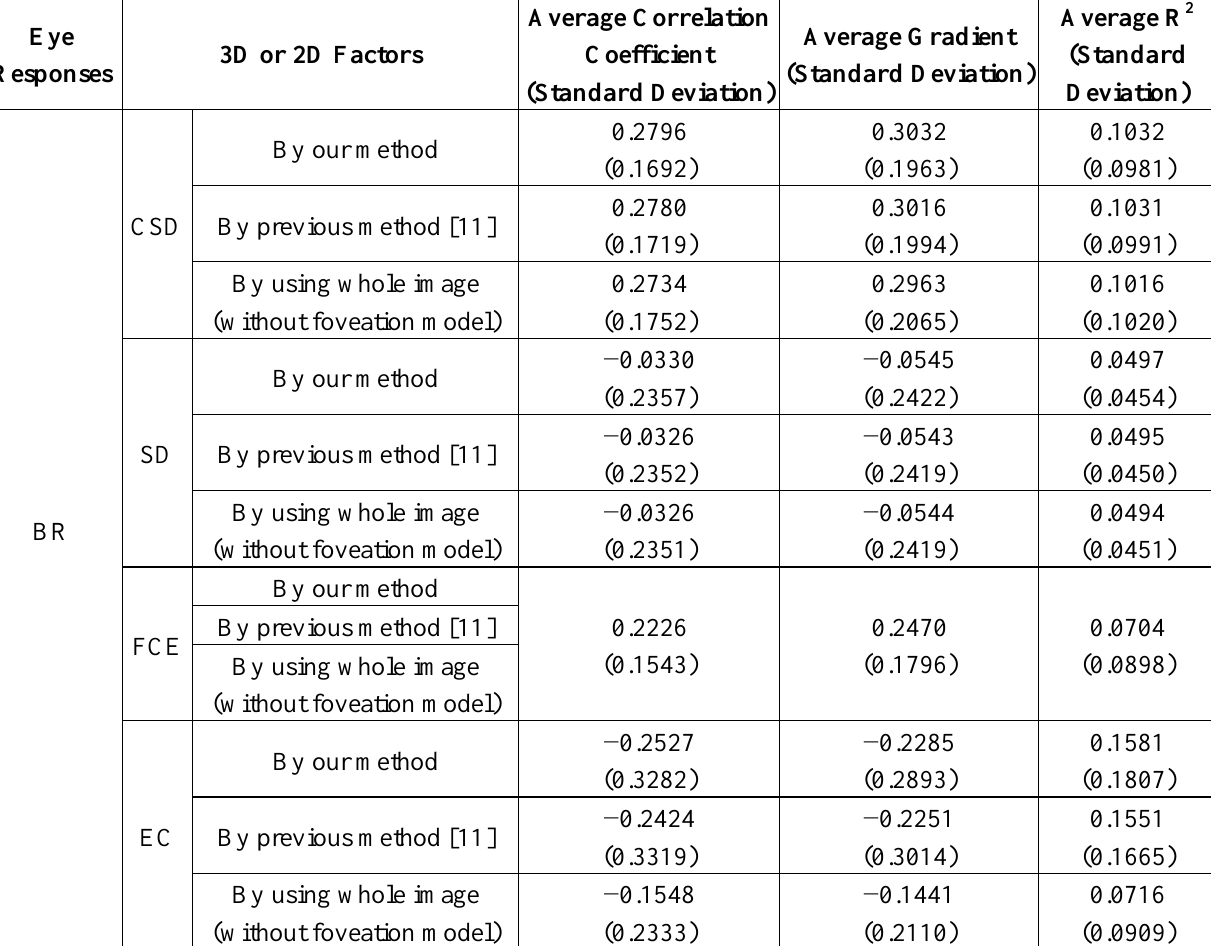
Table 6. Correlation between BR and factors for causing eyestrain on 3D display with the commercial 3D video used in Table 1 based on the gaze position that is